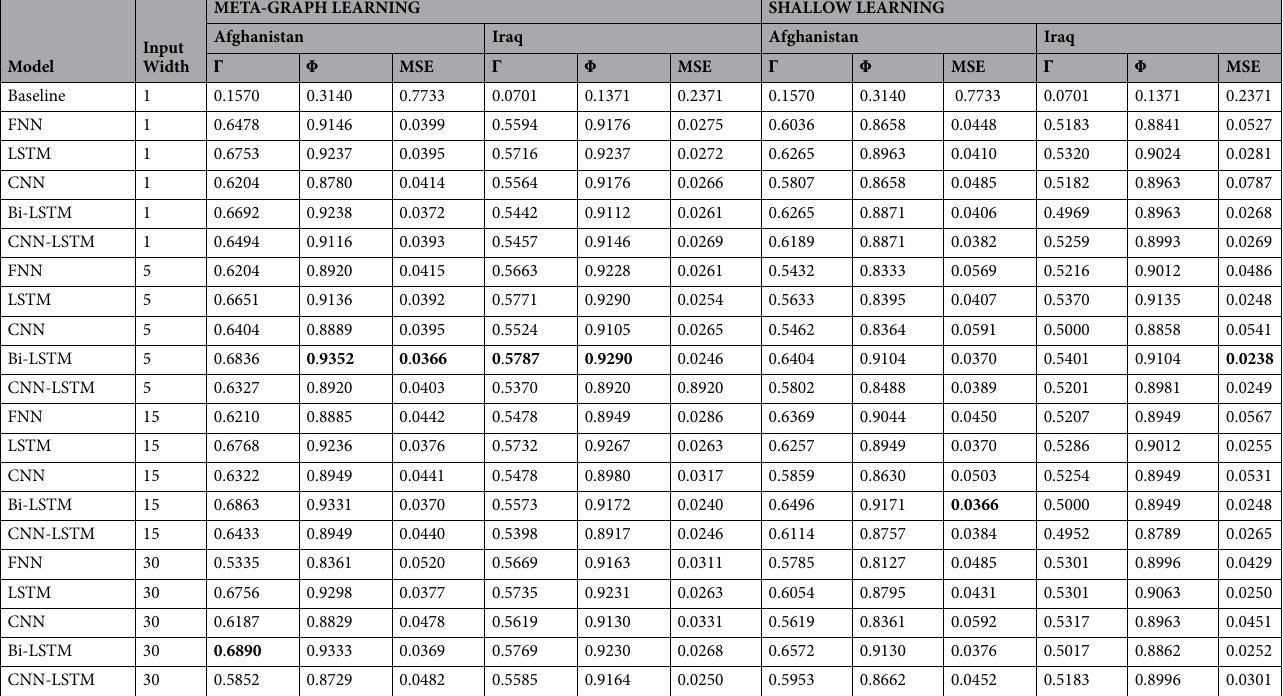
Table 2. Performance in terms of set-wise accuracy ( Ŵ ), event-wise accuracy ( (cid:31) ) and mean squared error (MSE) across chosen algorithms with varying input widths. For Ŵ and (cid:31) , higher values mean better performance. The contrary holds for MSE. Values in bold indicate the best performance obtained in each country overall (i.e., taking into consideration also Shallow datasets).